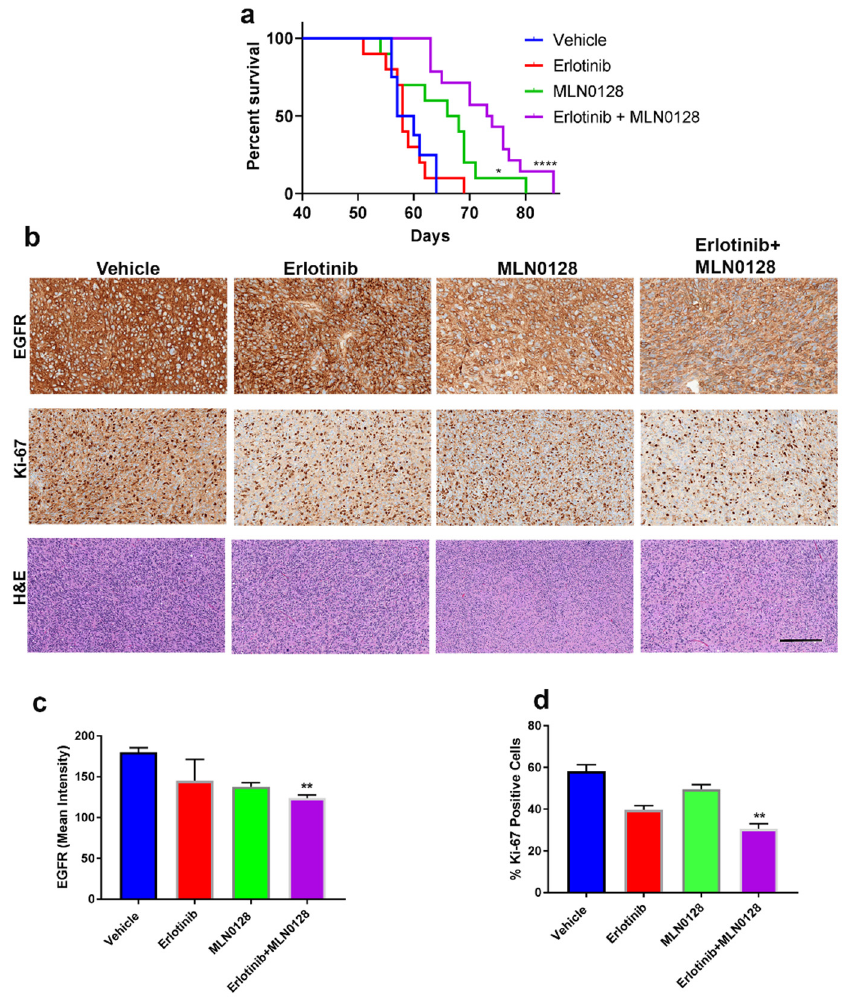
Figure 3. The combination of erlotinib and MLN0128 significantly inhibits GBM growth in vivo, in an orthotopic murine model of glioma. ( a ) Kaplan–Meier survival analysis of mice bearing intracranial GBM192 derived gliomas and treated with either drug alone or the combination of erlotinib and MLN0128. The treatment schedule is detailed in the methods section. * p = 0.02; **** p < 0.0001 (log-rank Mantel–Cox test). ( b ) Representative photomicrographs of immunohistochemical detection of EGFR (upper panels) and Ki-67 (middle panels) in GBM192 PDX samples from mice treated as indicated. Lower panels represent H&E staining for the same groups. Bar = 150 µ m. ( c ) Quantifica- tion of EGFR intensity levels in the four different groups. Four low-magnification fields/sections were counted. We used three sections/mouse and three mice/group. ( d ) Ki-67 quantification was performed as described for EGFR, counting positive nuclei and calculating % positive from total nuclei. ** One-way ANOVA p < 0.05 (combination vs.